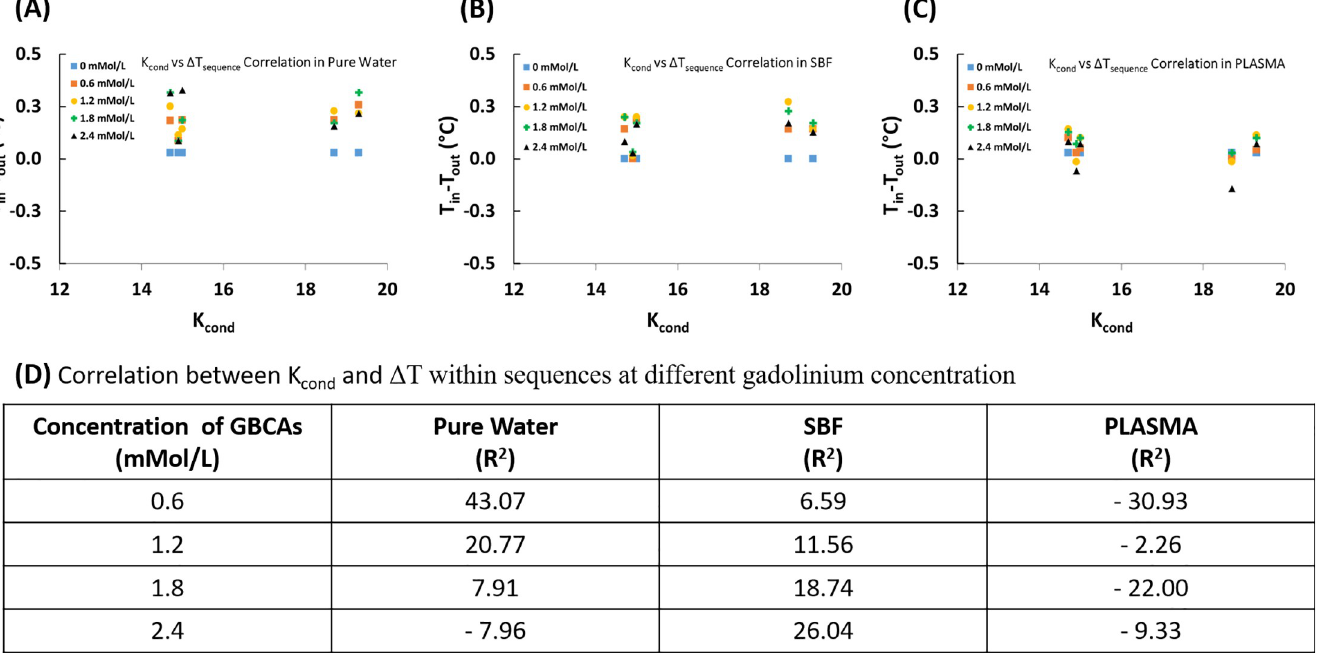
PLOS ONE | https://doi.org/10.1371/journal.pone.0214910 April 4,